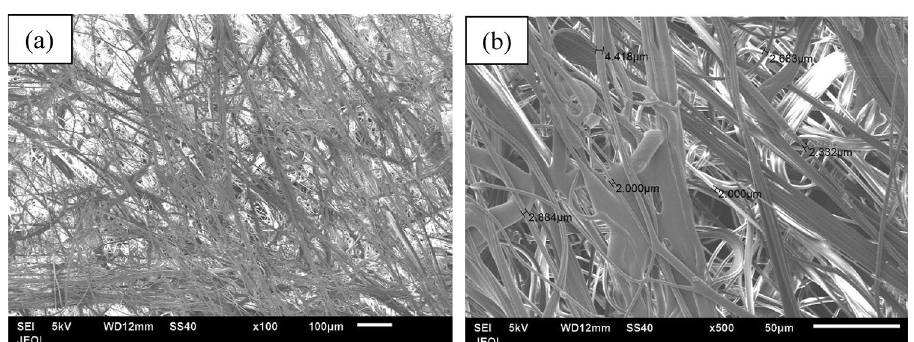
Figure 10. The middle layer fibers at two different magnifications; ( a ) at × 100 and ( b ) at × 500 showing the average size of the fibers.